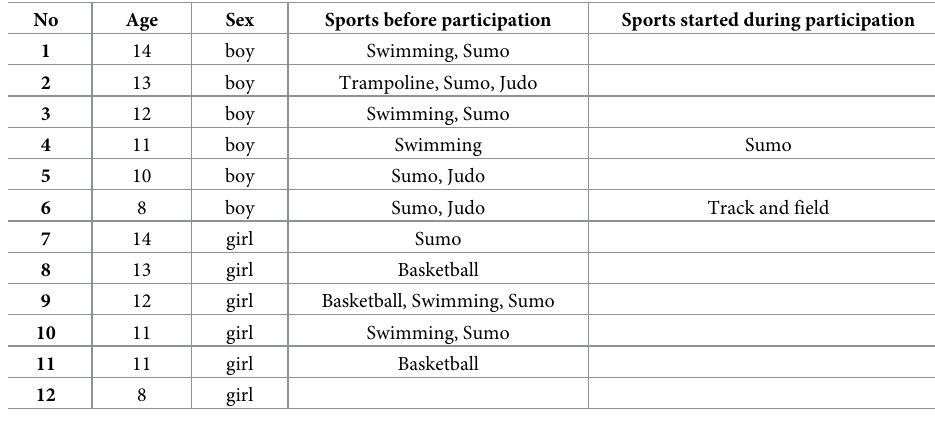
Table 1. Participant